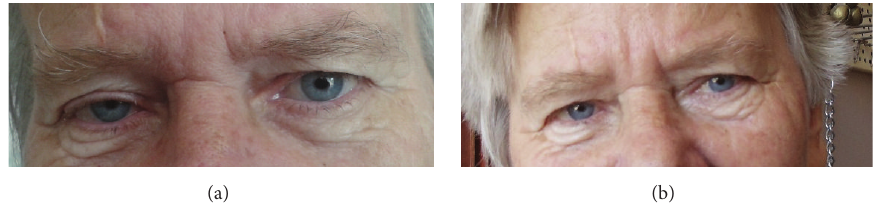
Figure 3: Patient with miosis and blepharoptosis one day after surgery (a). Restoration was achieved four weeks after operation